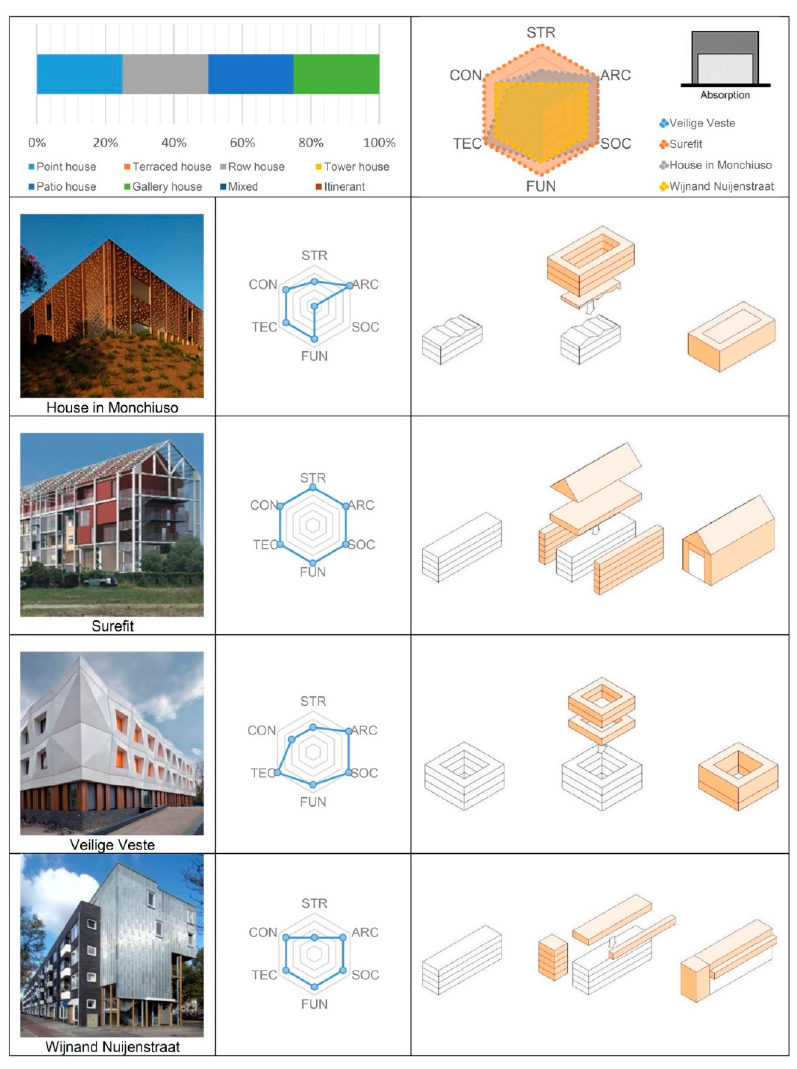
Figure 7. Example of a synoptic table.